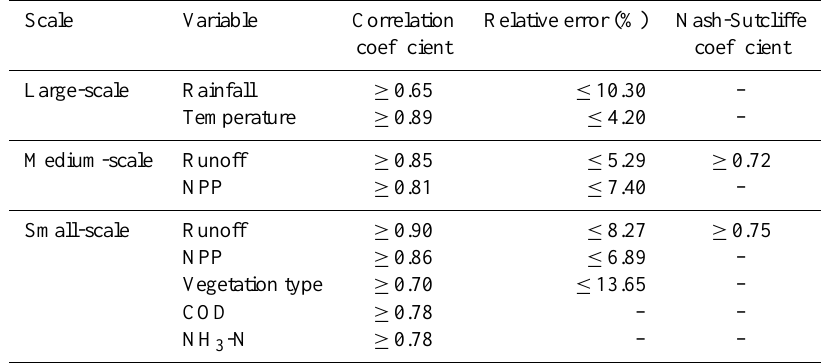
Table 4. Results of model